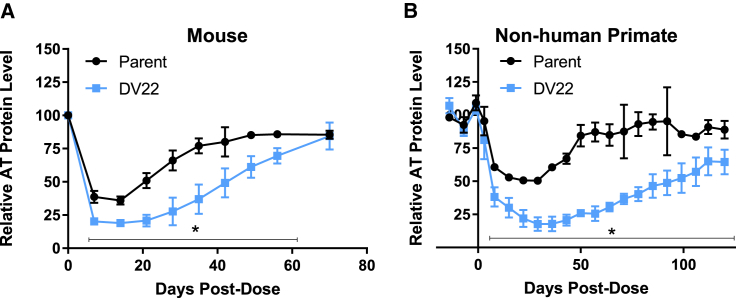
Application of New Design DV 22 to siRNA-Targeting AT(A) Mice (n = 3 per group) were treated with a single dose (1 mg/kg) of parent or the DV 22-based derivative. Serum AT levels were assessed by ELISA. (B) Cynomolgus monkeys (n = 3 per group) were treated with a single dose (1 mg/kg) of parent or its DV 22-based derivative, and plasma AT levels were assessed by AT activity assay. Data were analyzed by two-way ANOVA, followed by Dunnett’s (A) or Sidak’s (B) post-test. Time points at which a significant difference was observed between parent and DV 22 are noted with an asterisk. Error is represented as the SD.